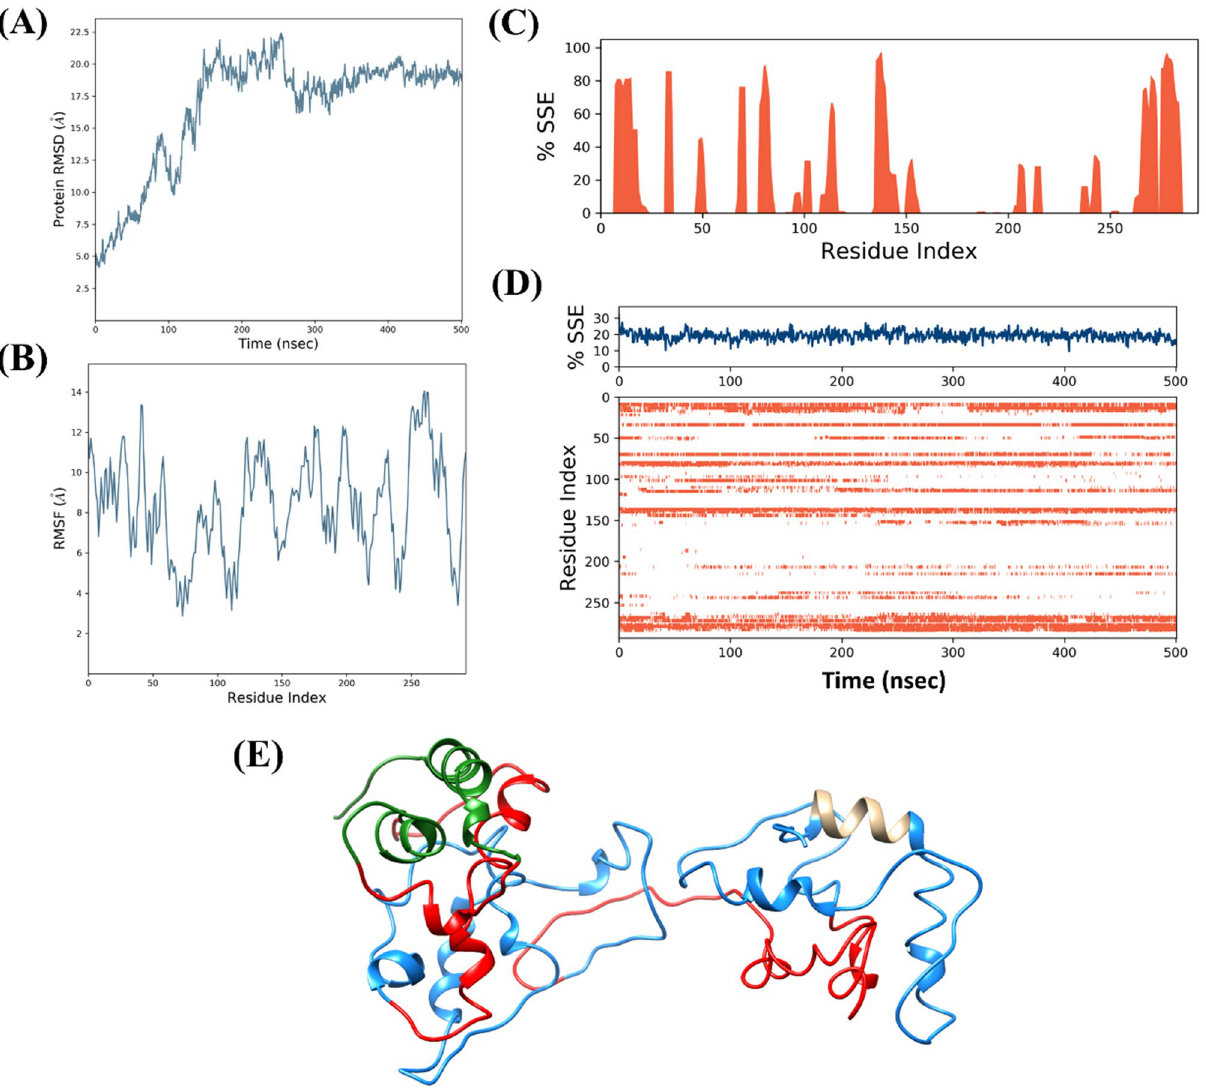
Figure 8. Molecular dynamic (MD) simulations analysis of Phosphoprotein (P): ( A ) root mean square deviation (RMSD), ( B ) root mean square fluctuation (RMSF) , ( C ) percentage secondary structure element (SSE; red color peaks show alpha helix) of phosphoprotein, ( D ) Timeline representation of secondary structure with respect to time, and ( E ) Last frame at 500 ns showing mostly unstructured regions after simulations. The disordered (IDPRs), MoRFs residues and MoRFs in IDP predicted regions are shown in red, tan and green colors,